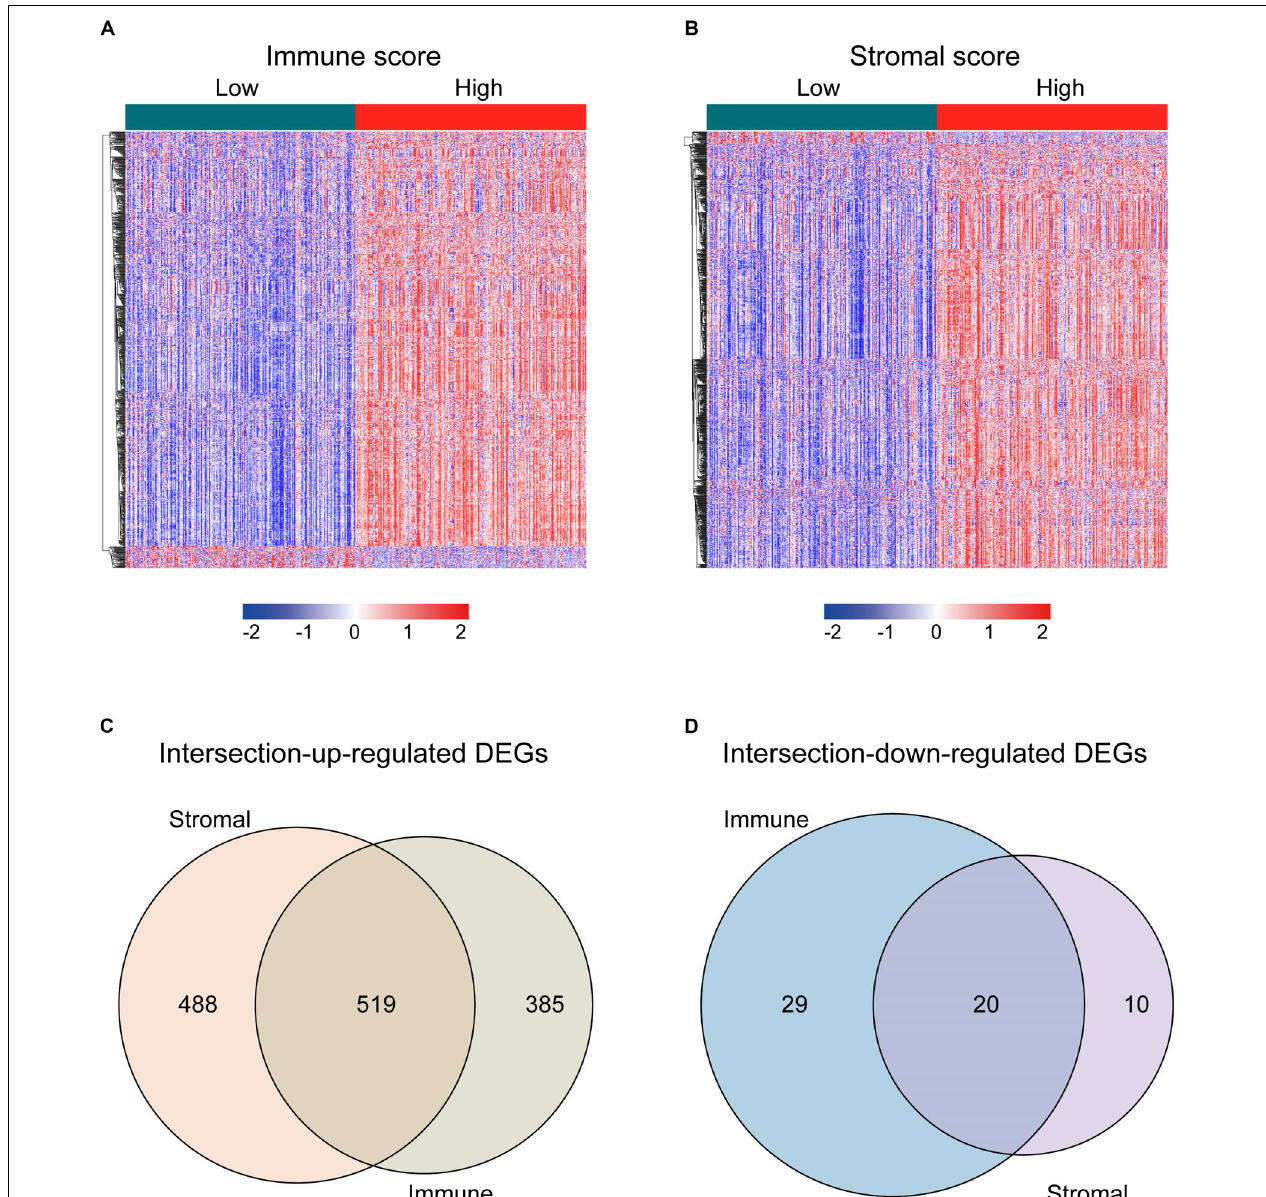
FIGURE 2 | Identification of the intersection DEGs among immune and stromal scores in LUAD. (A) Heatmap of the DEGs of immune scores of top half (high score) vs. bottom half (low score). Cutoff: | log2(fold-change)| > 1, FDR < 0.05. (B) Heatmap of the DEGs of stromal scores of top half (high score) vs. bottom half (low score). Cutoff: | log2(fold-change)| > 1, FDR < 0.05. (C,D) Venn diagrams showing the number of intersection-upregulated DEGs ( C ) or intersection-downregulated DEGs ( D ) in stromal and immune score groups. Heatmaps were drawn based on the average method and correlation distance measurement method. Genes with higher expression are shown in red, lower expression are shown in blue, genes with the same expression level are in white. DEGs, differentially expressed genes; LUAD, lung adenocarcinoma; FDR, false discovery